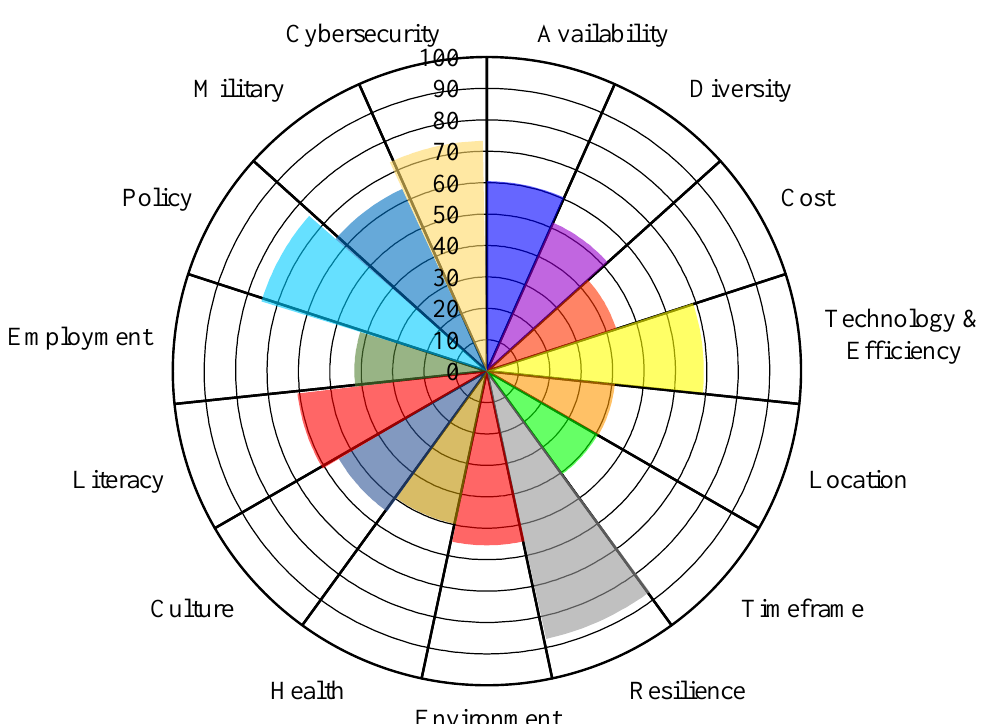
Figure 19. Detailed energy security view for the United States, values 0–100 represent worst to best.